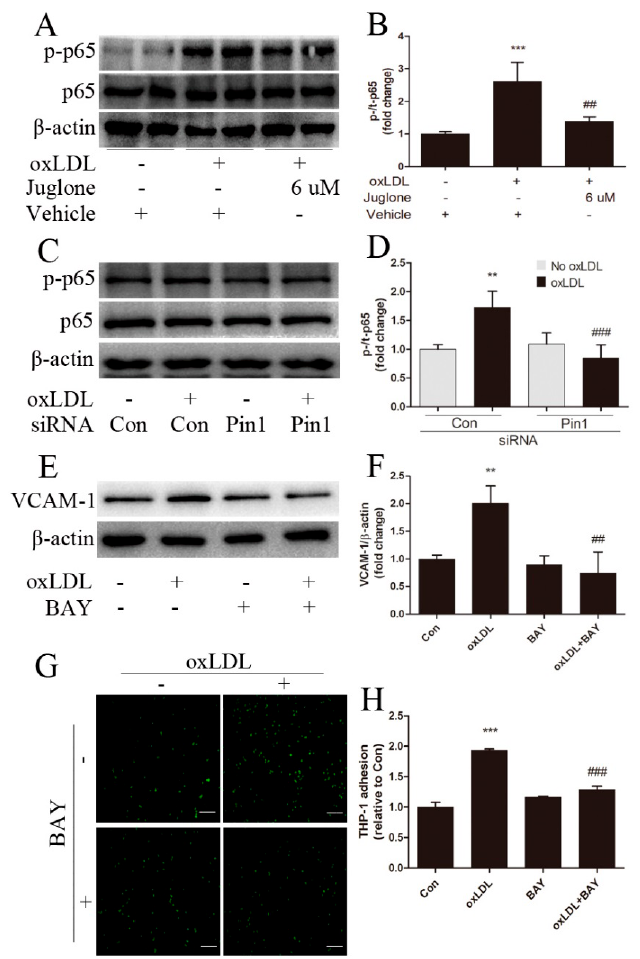
Figure 4. The role of NF- κ B signaling in Pin1-regulated inflammatory response induced by oxLDL in EA.hy926 cells. NF- κ B signal transduction in endothelial cells stimulated with oxLDL (50 µ g/mL)